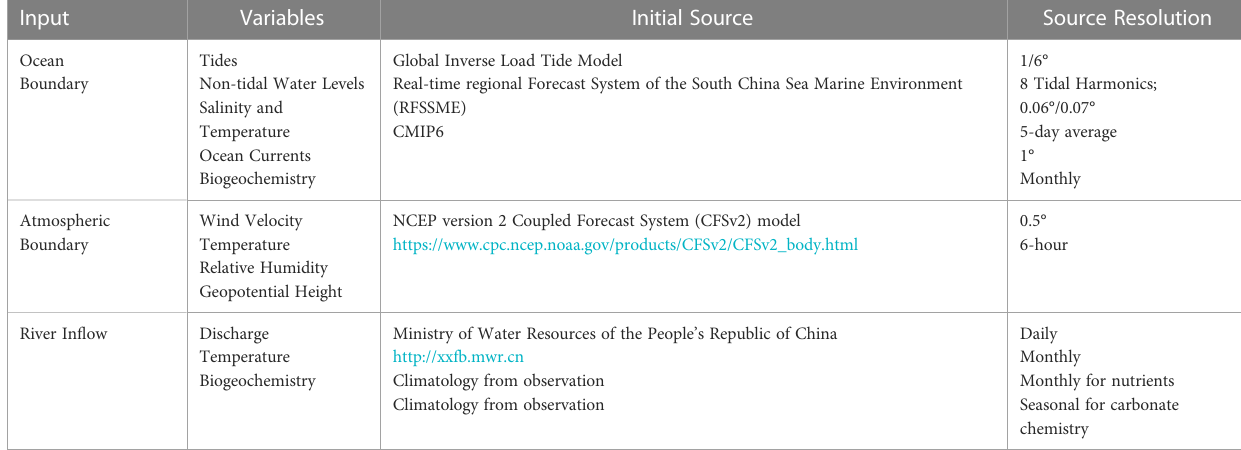
TABLE 1 Major boundary conditions and inputs required to run the atmosphere – ocean circulation – carbon biogeochemistry model.